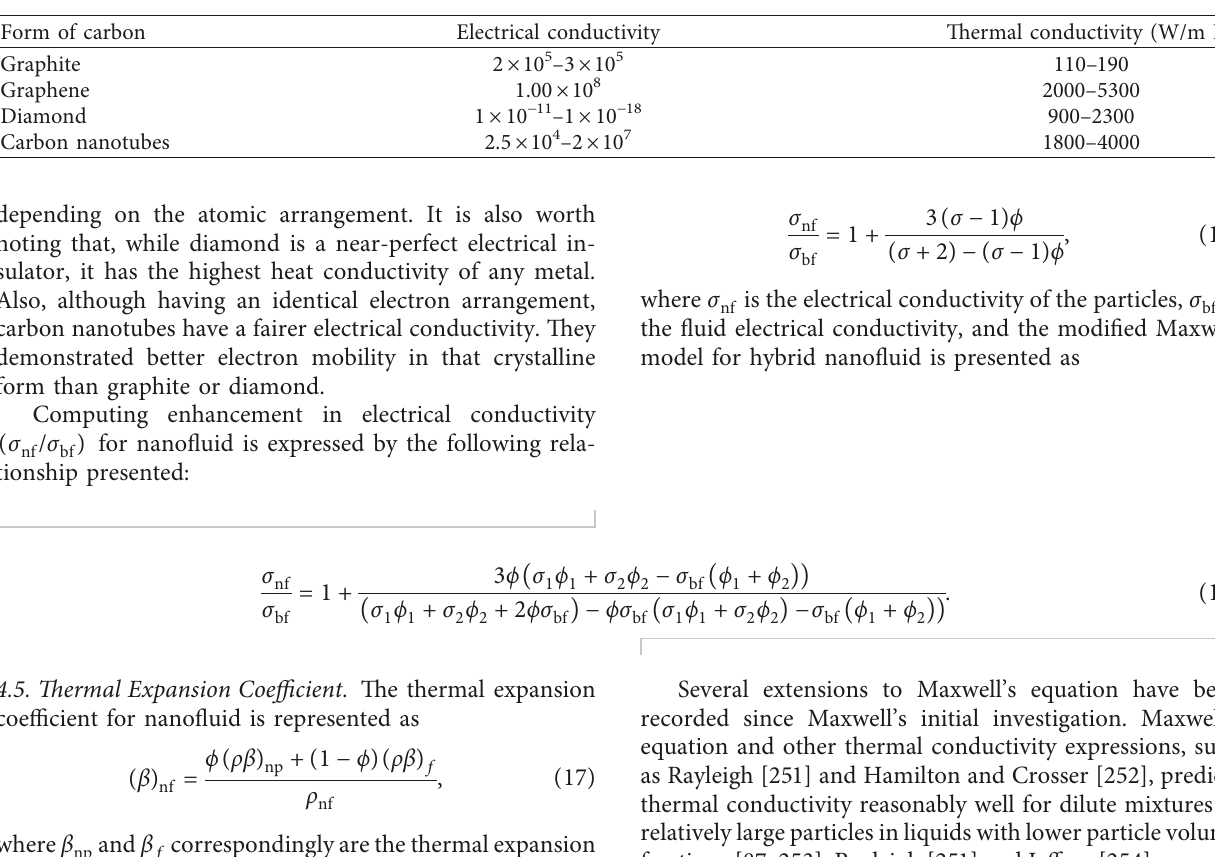
Table 7: Electrical and thermal conductivities of some carbon-based materials at